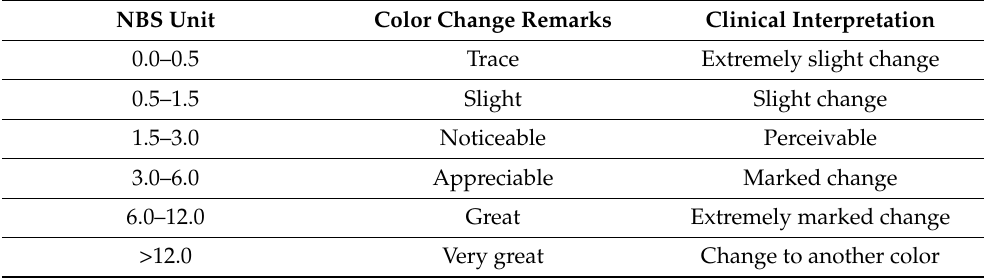
Table 1. NBS interpretation of color